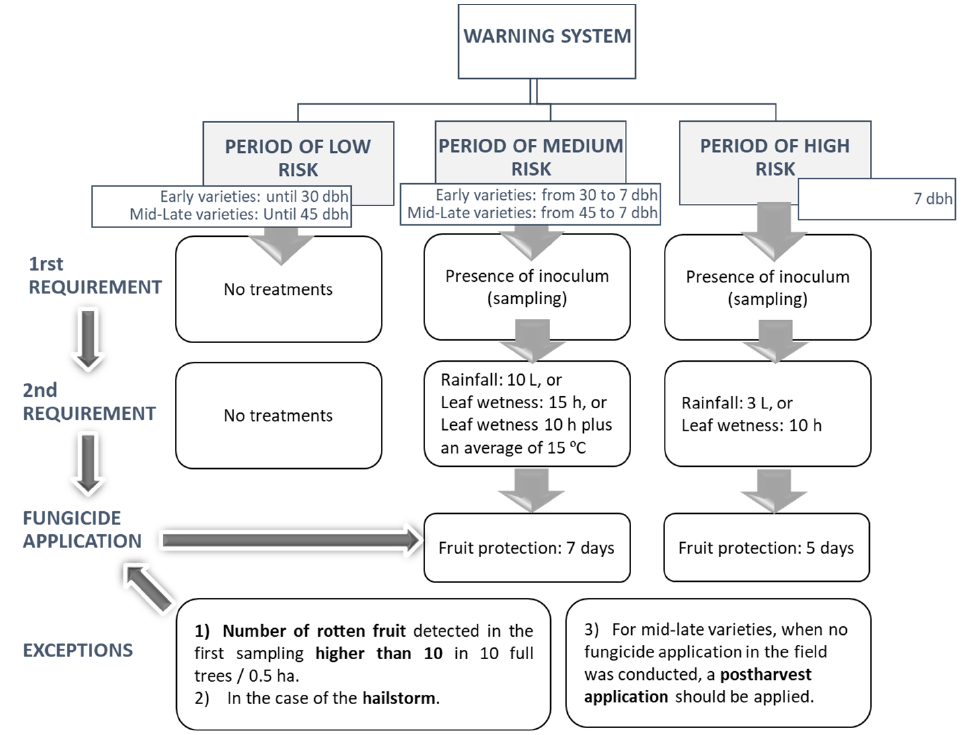
Figure 1. Diagram of the warning system designed and validated. Note: dbh means days before harvest.